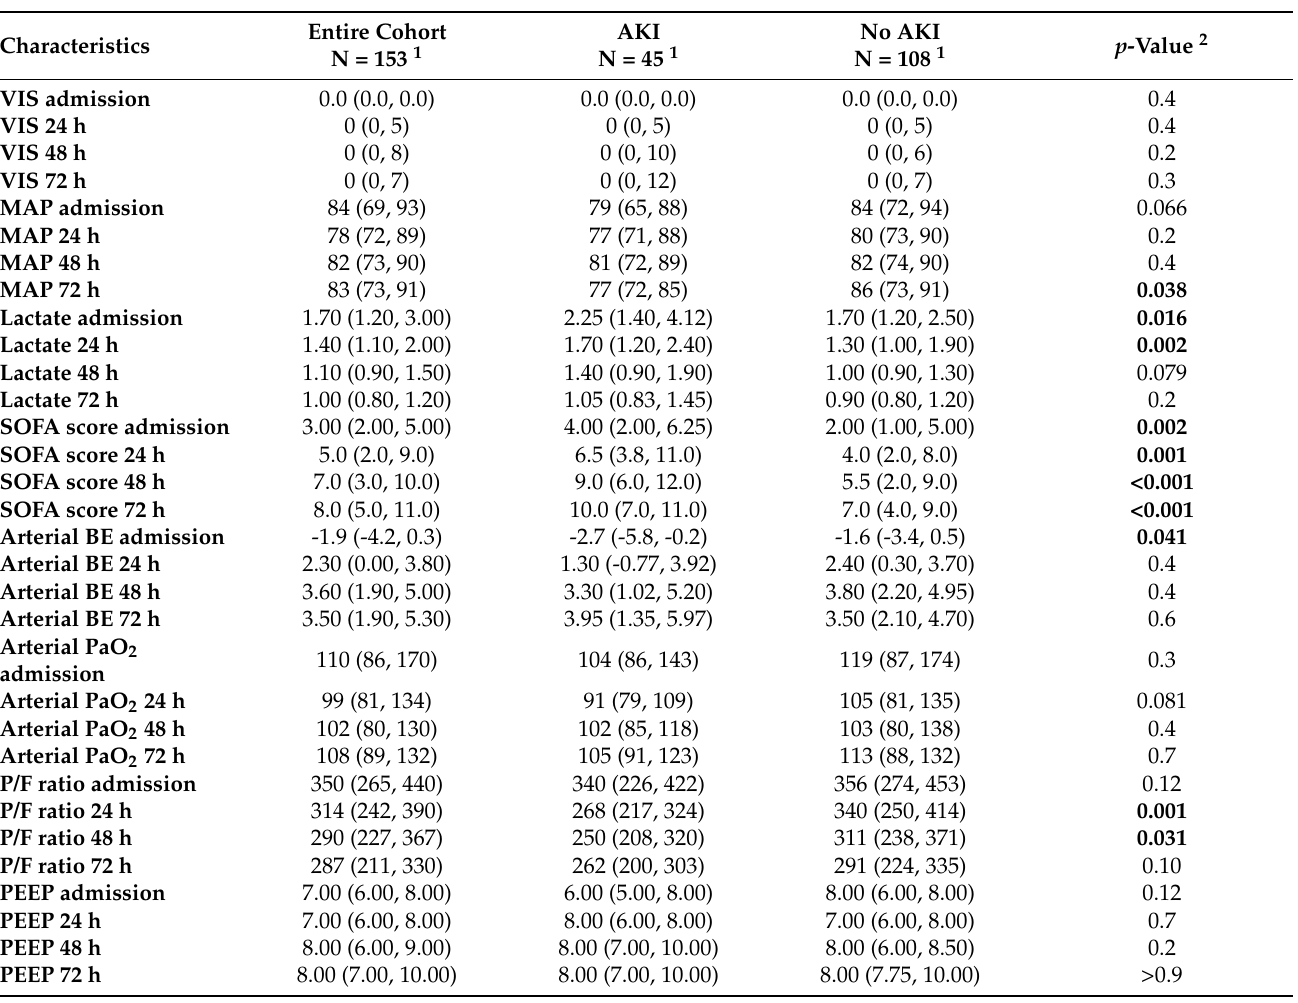
Table 3. ICU admission scores for organ failure, hemodynamic data, and respiratory variables in the entire cohort and according to AKI.